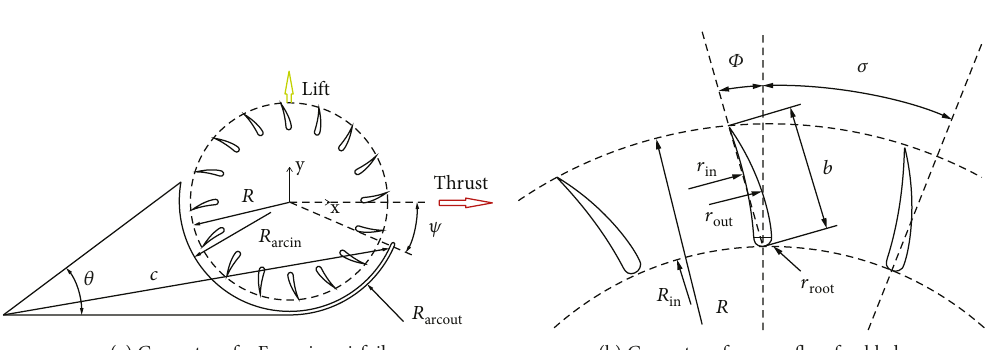
Figure 4: Fan-wing.